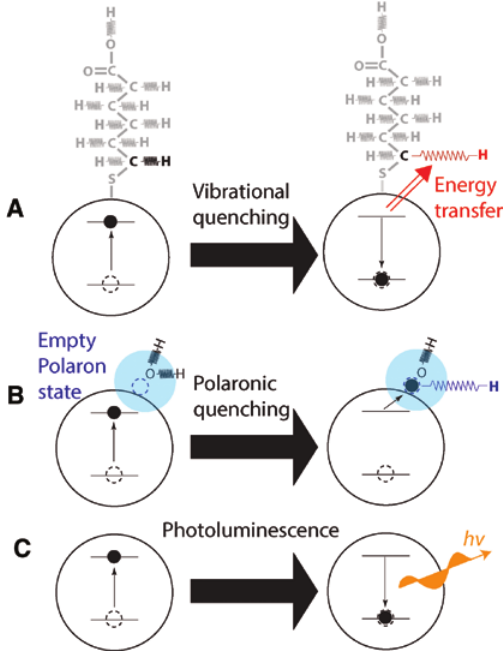
Figure 5: Exciton relaxation pathways in quantum dots photolumi- nescent in the